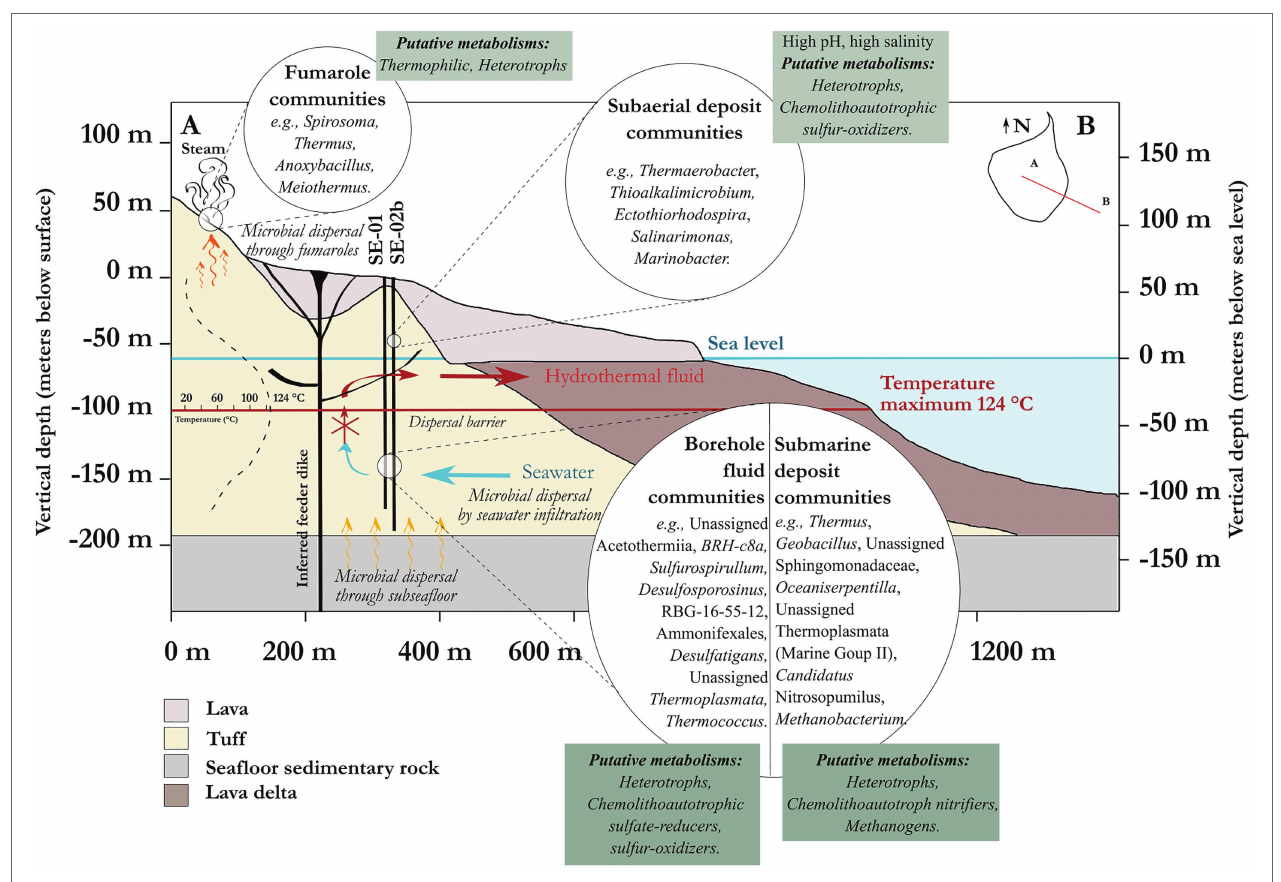
FIGURE 7 | Overview of the putative metabolisms and microbial dispersion scenario of the subsurface of Surtsey